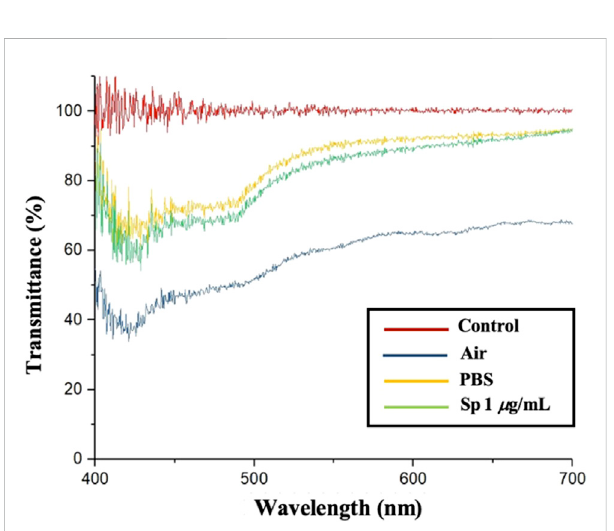
FIGURE 3 Cholesterol liquid crystal device penetration spectrum.